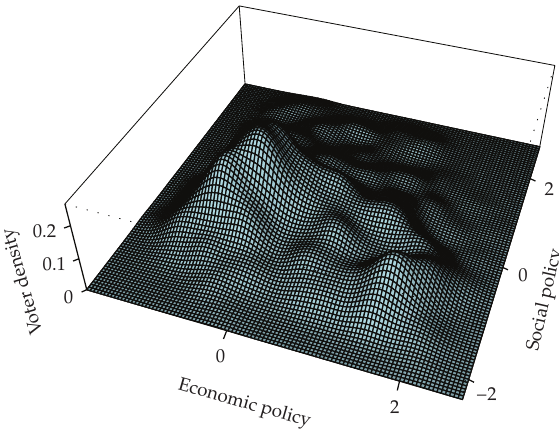
Figure 3: Perspective plot of the sample electorate in 2008.